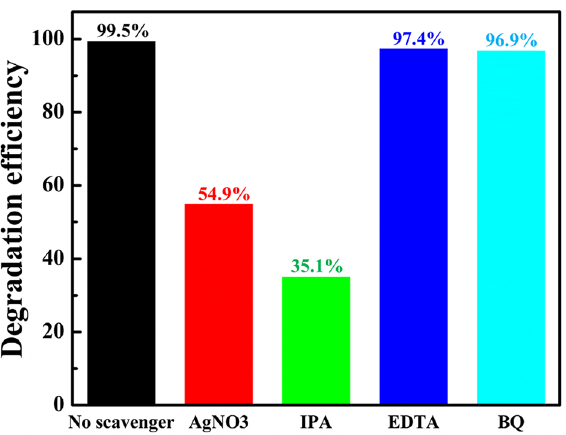
Figure 7. Effect of various of scavengers on the degradation of MB by 20N-KBFO + H 2 O 2 + L-Cysteine.